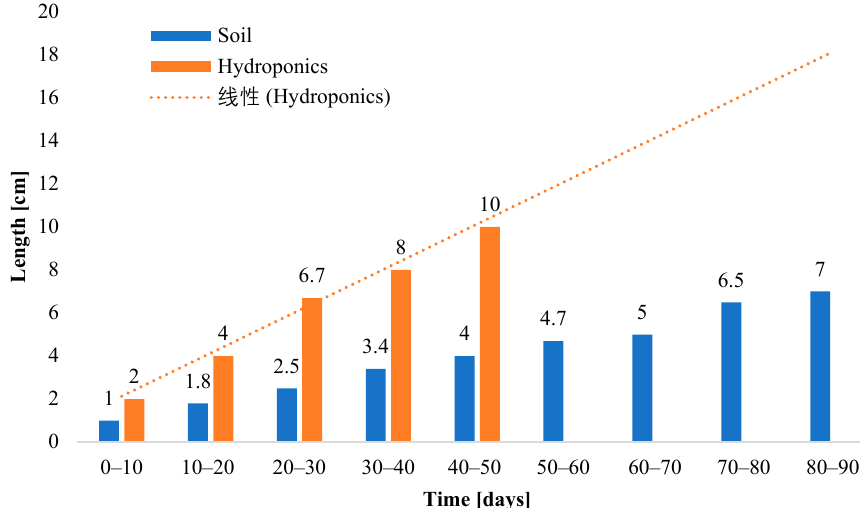
Figure 15. Comparison of romaine lettuce leaf length in cm grown in soil and the NFT hydroponic setup concerning time in days since sowing. A graphical representation of the periodic growth of leaf length in soil and